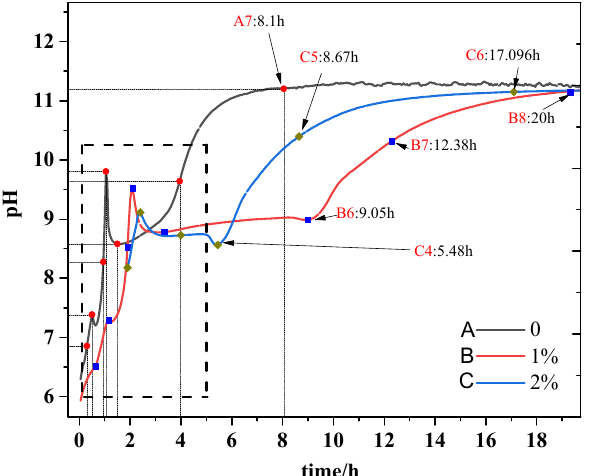
Figure 2. Evolution of pH over time for MPC diluted suspension mixed with different concentrations of sodium alginate.